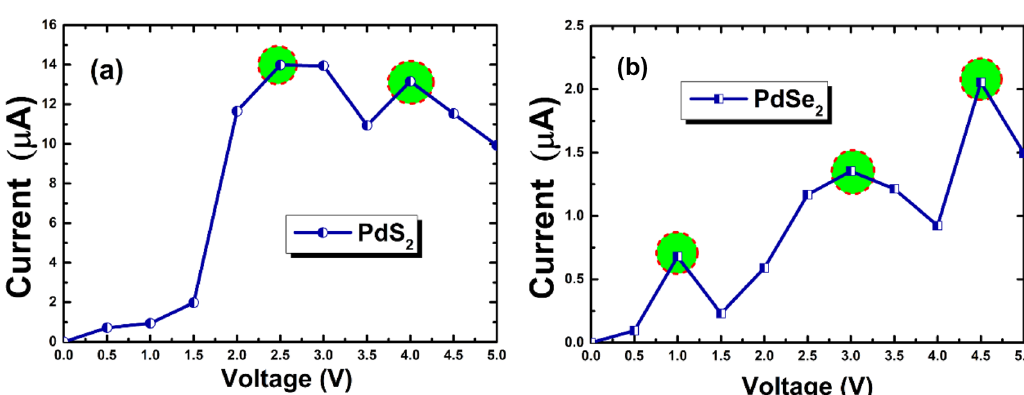
Figure 6. Current–voltage ( I-V ) plot of penta-PdQ 2 under bias voltages from 0.0 V to 5.0 V. The negative differential conductance (NDC) regions are indicated by the highlighted